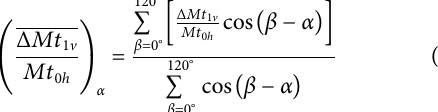
FIGURE 3 | Curves of average momentum gain and loss of particle collision motion with